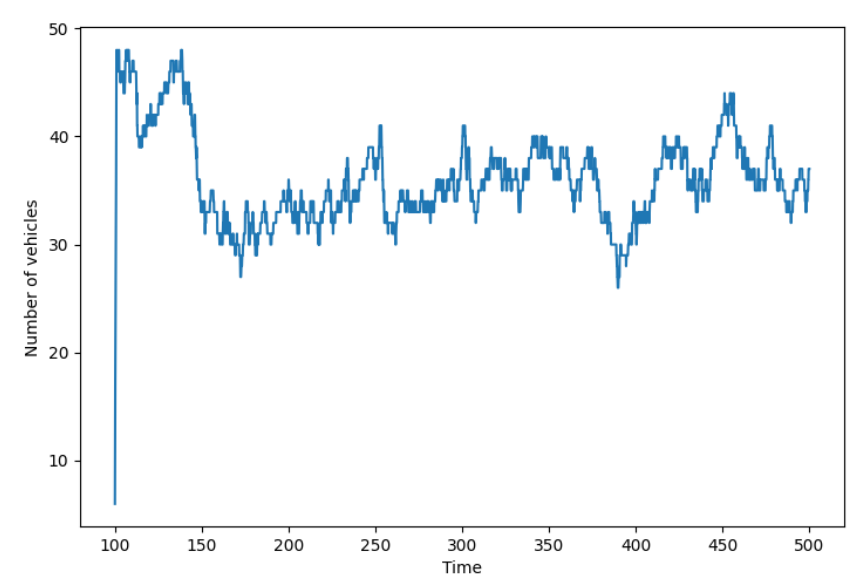
Figure 8. The number of vehicles in the simulation in the urban grid